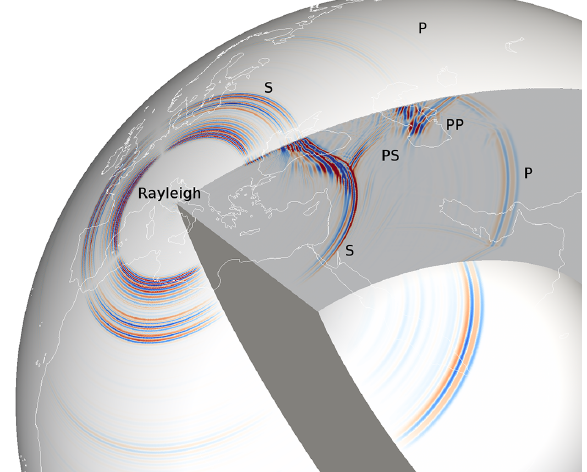
Figure 13. Snapshot of a 3-D wavefield emanating from a strike-slip event in Italy after 400s. The background model is the isotropic, anelastic PREM, and the simulation is done at a dominant period of 10s. Note the effect of the radiation pattern on the wavefield in 3-D. Similar snapshots are automatically generated in the post- processing of AxiSEM. A movie is available as supplementary ma-